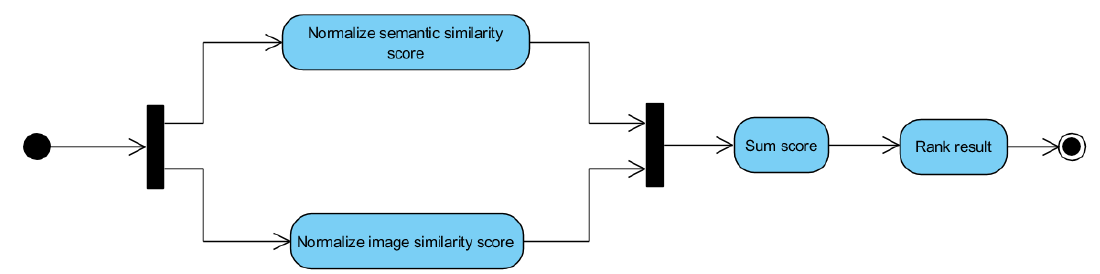
Figure 10. Activity diagram: sum